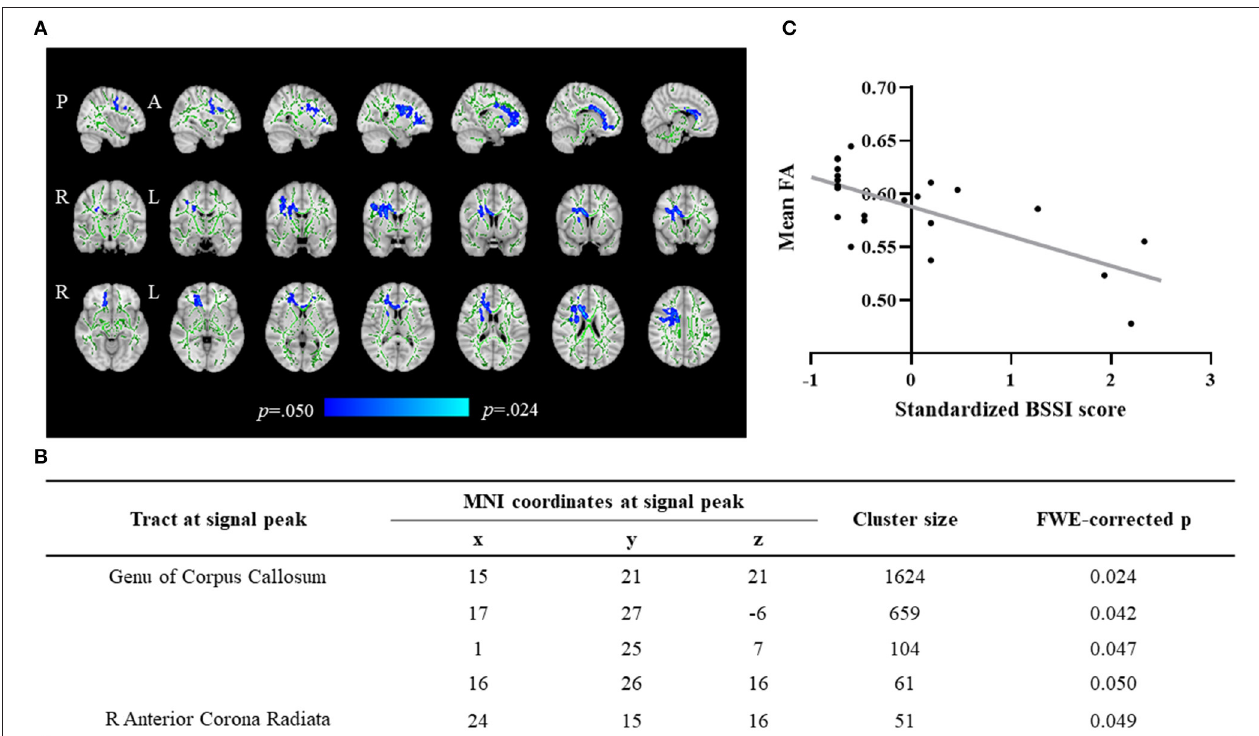
FIGURE 3 | Tract-based spatial statistics (TBSS). (A) Significant negative correlation between suicidal ideation and FA maps in drug-naïve patients with Major Depression (adjusted for age, sex, and years of education). Blue/light-blue voxels indicate a significant decrease in FA. Significance threshold was set to p < 0.05 (FWE-R correction for multiple comparisons). The WM skeleton (represented in green) is superimposed on a T1-weighted MNI template. (B) Table illustrating the clusters negatively associated with suicidal ideation score. (C) Scatterplot illustrating the negative correlation between FA of the significant clusters and suicidal ideation score. The x-axis represents average values of FA and y-axis the standardized suicide ideation severity score on BSSI. The gray line represents the overall regression